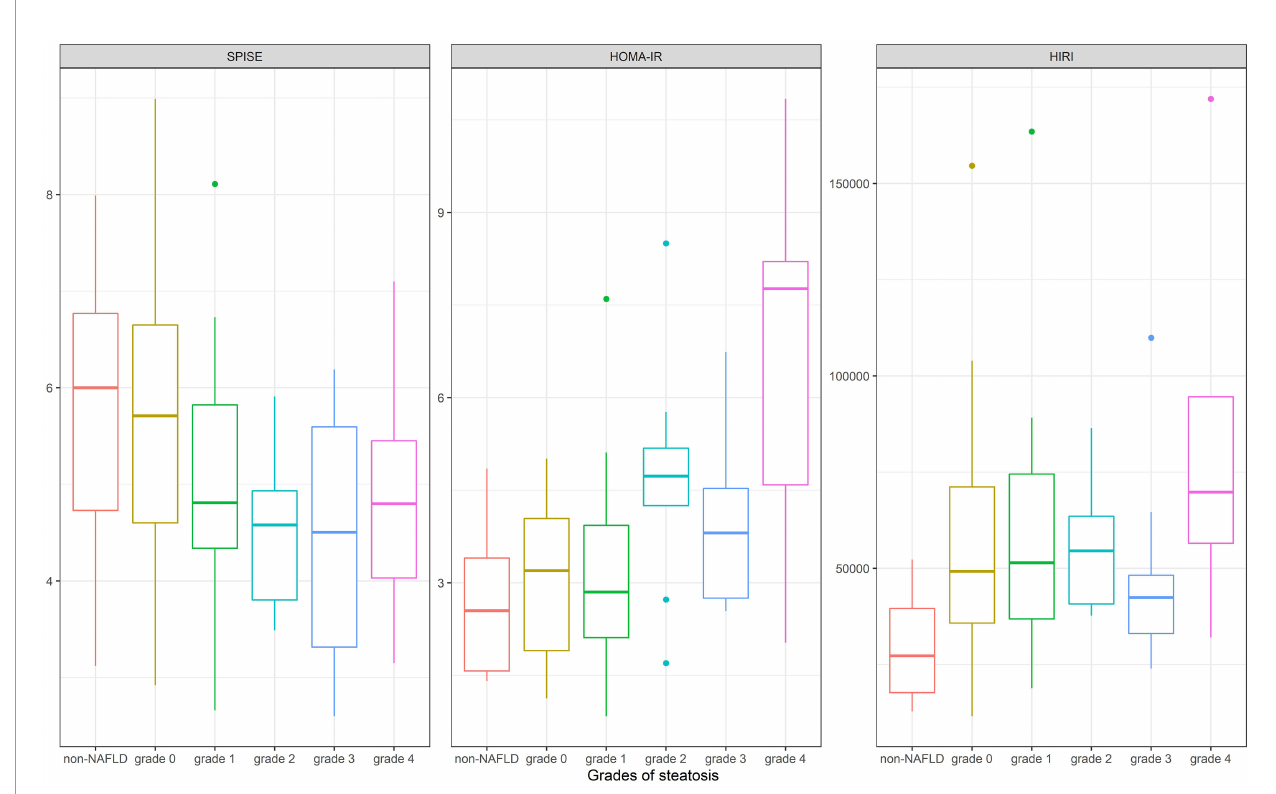
FIGURE 1 | Comparison of the performance of SPISE, HOMA-IR and HIRI according to different steatosis grades [non-NAFLD: liver fat content (LFC) < 2.6%; grade 0: LFC 2.6 - ≤ 5%; grade 1: LFC >5 - ≤ 9.2%; grade 2: LFC >9.2 - ≤ 15.1%; grade 3 : LFC >15.1 - ≤ 26.8%; grade 4: LFC >26.8%]. SPISE, Single Point Insulin Sensitivity Estimator; HOMA-IR, homeostatic Model Assessment for Insulin Resistance; HIRI, Hepatic Insulin Resistence Index; NAFLD, Non-alcoholic fatty liver disease; LFC, Liver fat content.